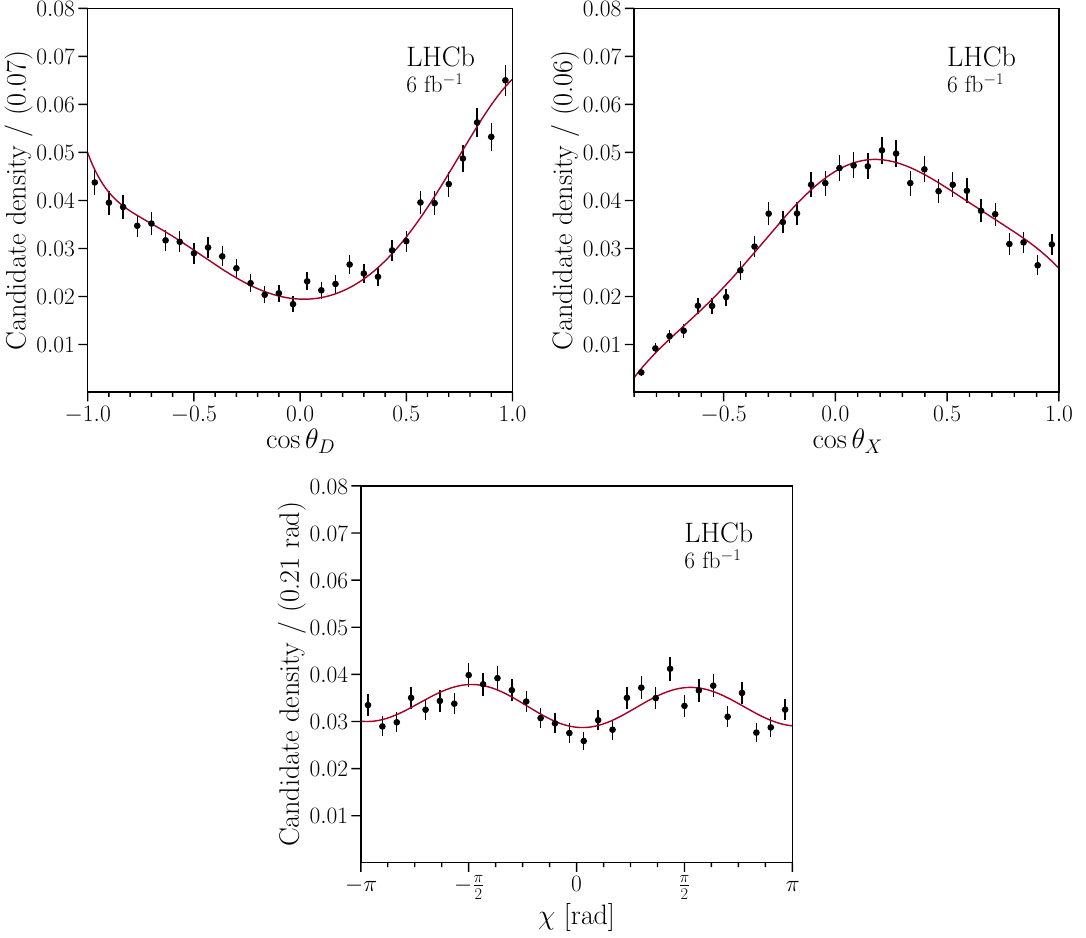
candidates in data, with s